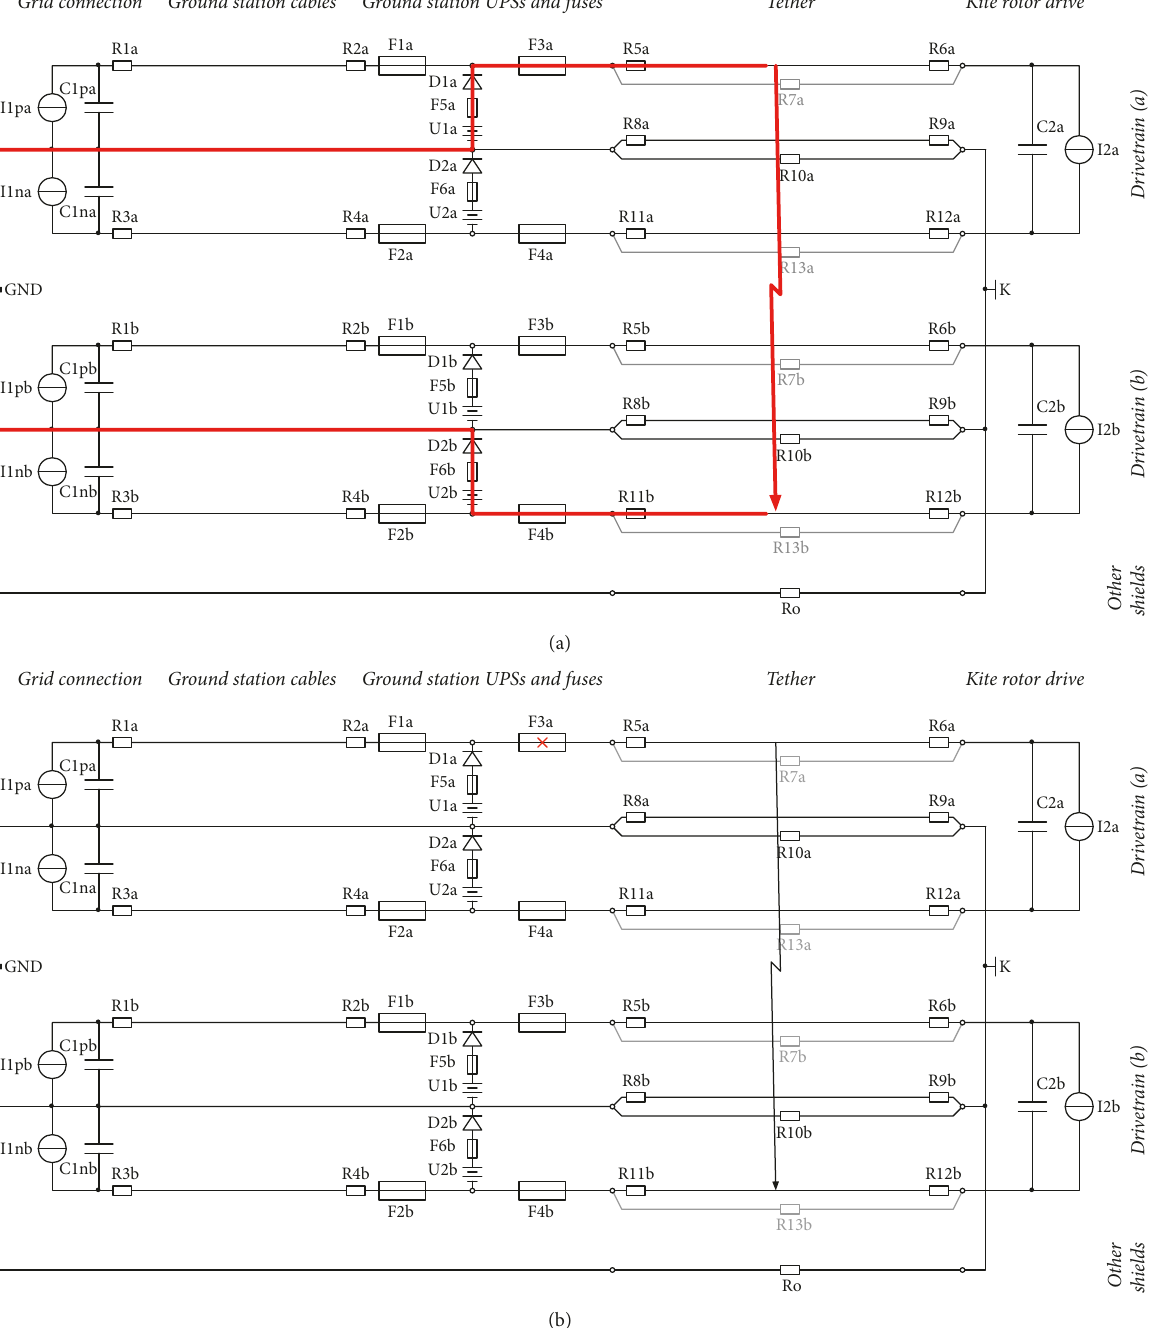
It should be noted that the differences of S7 in generator mode (not shown here) to the motor mode are similar to the differences between S2 in motor and generator